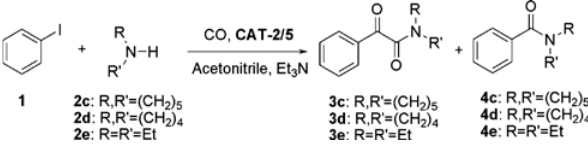
Scheme 3: Aminocarbonylation of iodobenzene ( 1 ) with aliphatic amines ( 2c–e ).